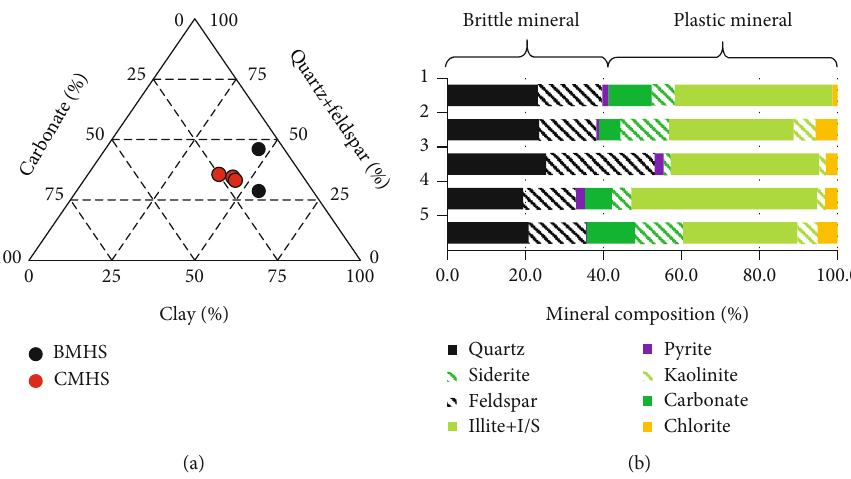
Figure 1: (a) Ternary diagram of mineralogy of shale specimens (BMHS: brittle mineral high shales; CMHS: clay mineral high shales); (b) histogram of di ff erent minerals (sample 1 shows the boundary of brittle and plastic mineral